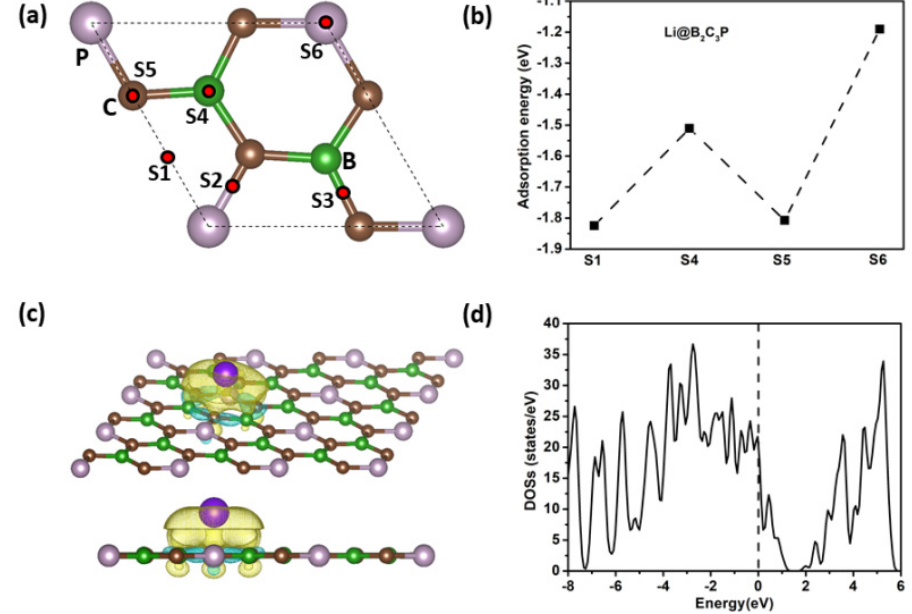
Figure 2. ( a ) The various sites for Li adsorption on the surface of the B 2 C 3 P. ( b ) Adsorption energies for Li on the surface of 2D B 2 C 3 P. ( c ) The charge density difference of the Li-adsorbed B 2 C 3 P. The yellow and blue areas denote the electron gain and loss with the iso-surface level of 0.002 eÅ − 3 . ( d ) The total density of states of B 18 C 27 P 9 Li.